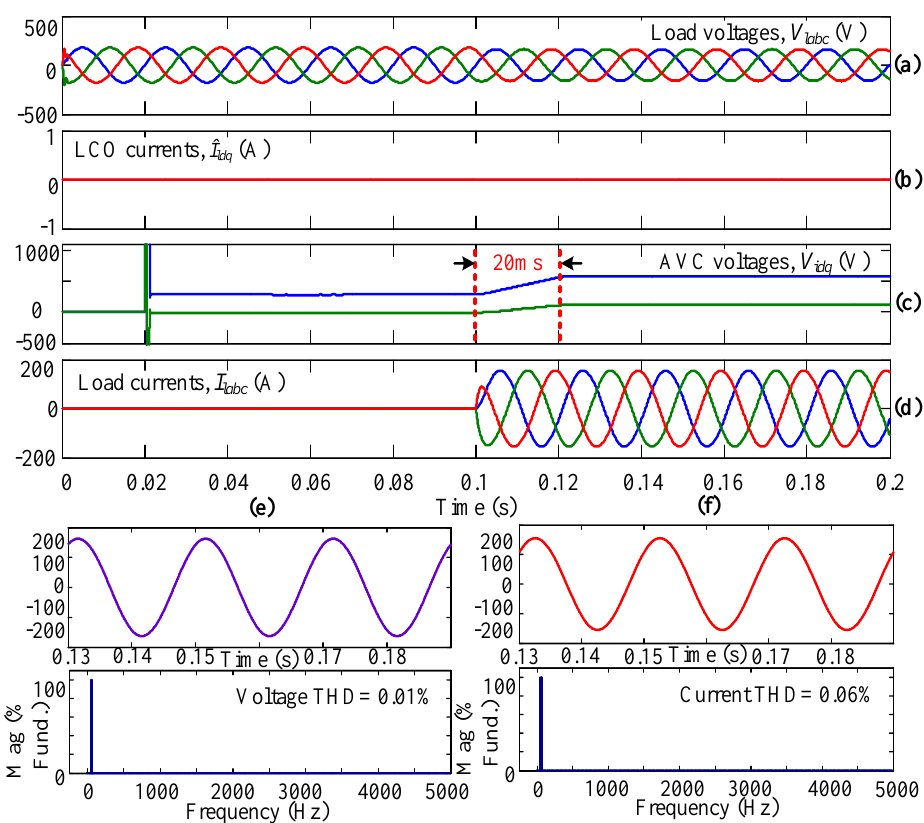
Figure 9. Simulation results for case-III with balanced load condition.